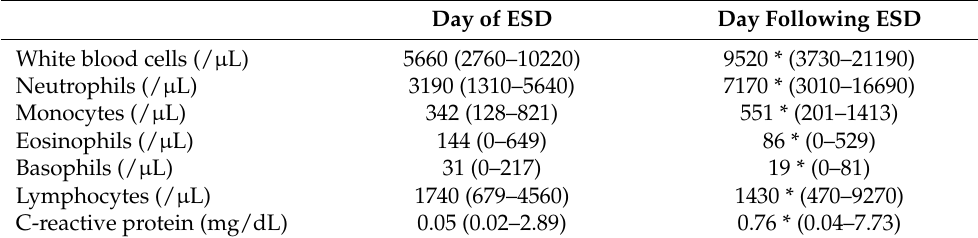
Table 3. Changes in white blood cells (neutrophils, monocytes, eosinophils, basophils, and lympho- cytes), and C-reactive protein.